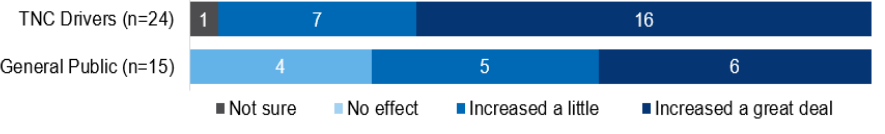
Figure 1. Event effect on likelihood of purchasing EV in next five years, by survey wave.